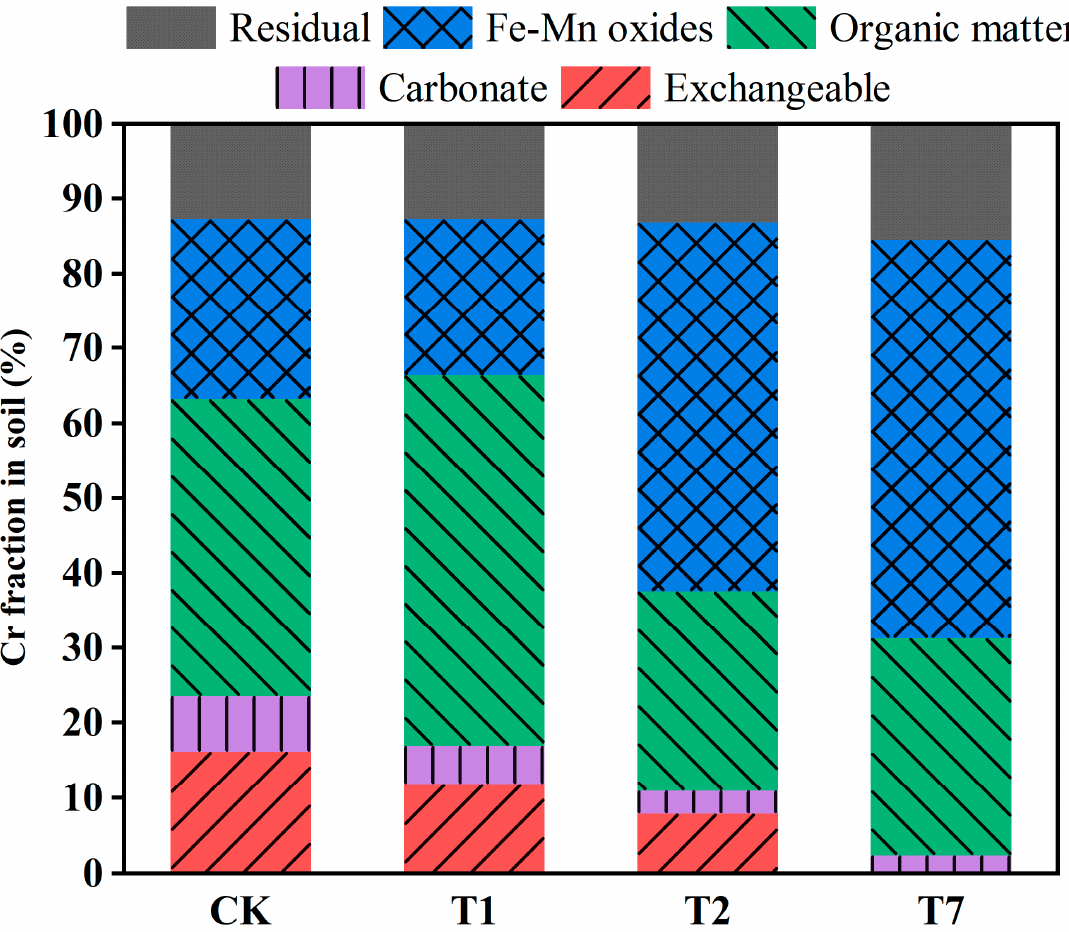
Figure 2. Effect of compound type on the distribution of chromium species in soil. (Soil without any additive (CK), RBC600, 10 g/kg (T1), nZVI, 10 g/kg (T2), BC-nZVI, 10 g/kg (T7)). The nZVI-remediated soil, T2, had 7.88% exchangeable, 3.18% carbonate bound, 26.54% organic bound, 49.27% Fe-Mn oxidized, and 13.13% residue states. Compared to CK, the exchangeable state in T2 decreased by 8.28% and the Fe-Mn oxidized state increased by 28.41%. This is mainly due to the adsorption of Cr ions from the soil on the surface of the nZVI particles after the nZVI remediation, which complexes and precipitates with the surface Fe oxides as well as Fe hydroxides to form trivalent Cr-Fe hydroxides [31]. After the BC-nZVI remediation, the exchangeable state disappeared completely from the soil, i.e., T7, with 2.38% carbonate bound, 28.91% organic bound, 53.19% Fe-Mn oxidized, and 15.52% residue states. It can be found that almost all of the exchangeable state in T7 was transformed into Fe-Mn oxidized and residue states, in which the Fe-Mn oxidized